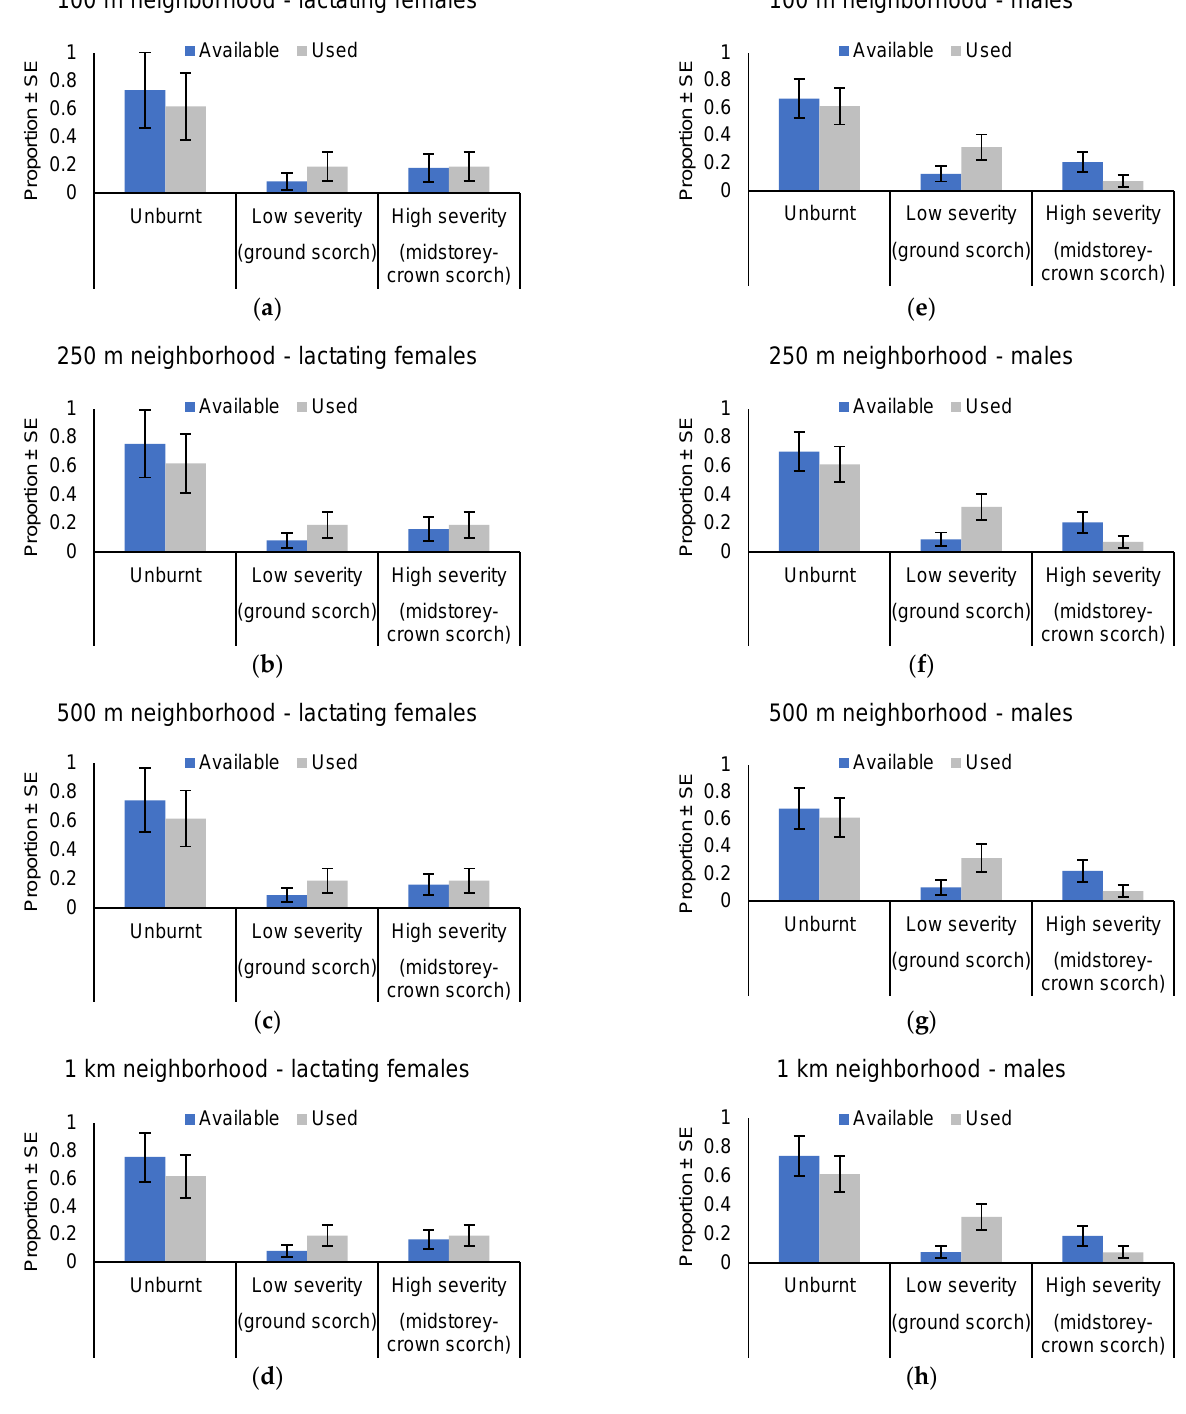
Figure 7. Column graphs illustrating the distribution of roost trees among the post-burn mosaic of unburnt, low severity burn, and higher severity burn. Data represent modeled estimates of means after accounting for random variation associated with individual bats. Also shown are the relative proportions available within ( a ) 100 m neighborhood, ( b ) 250 m neighborhood, ( c ) 500 m neighborhood and ( d ) 1 km neighborhood of each female roost tree, and ( e ) 100 m neighborhood, ( f ) 250 m neighborhood, ( g ) 500 m neighborhood and ( h ) 1 km neighborhood of each male roost tree.